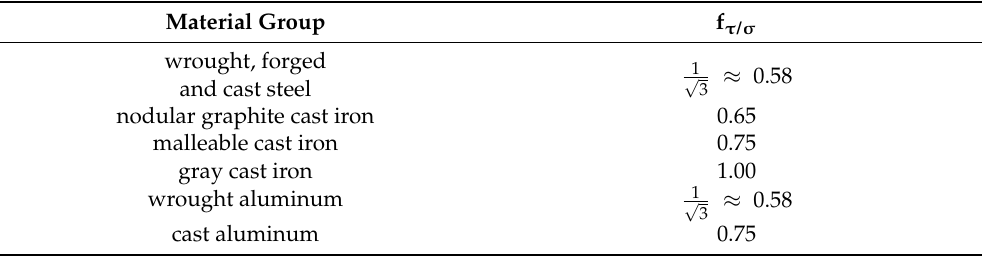
Table 1. General values for the ratio of endurance limits for shear and normal stresses according to FKM guideline [5].